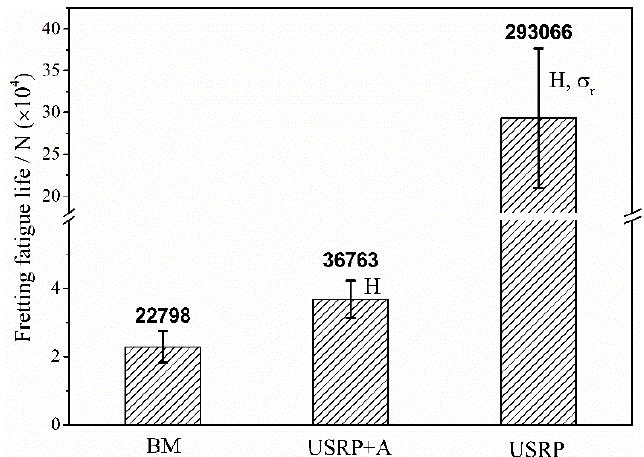
Figure 9. Fretting fatigue lives of Ti-6Al-4V alloy with different surface treatments at a maximum stress level of 500 MPa (H - surface work-hardening, σ r - compressive residual stress).